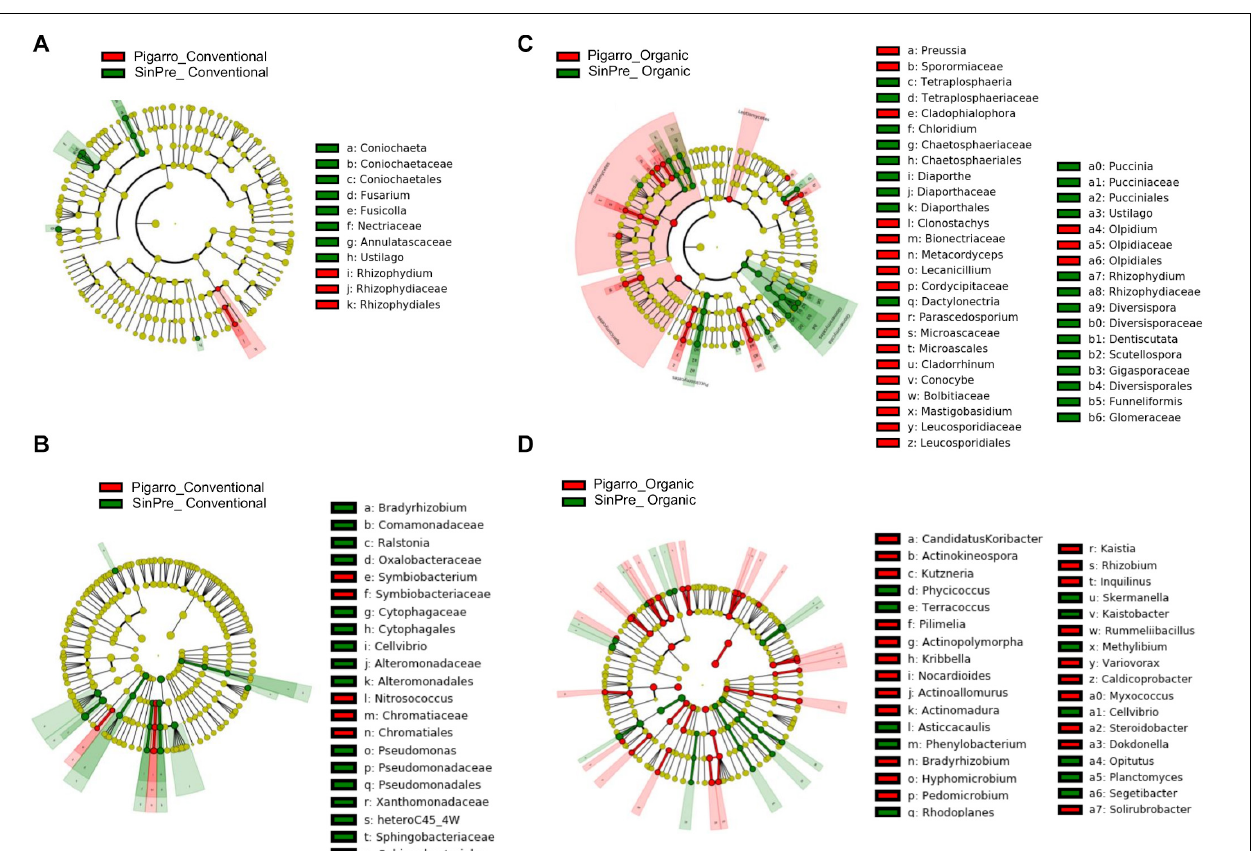
Frontiers in Microbiology |